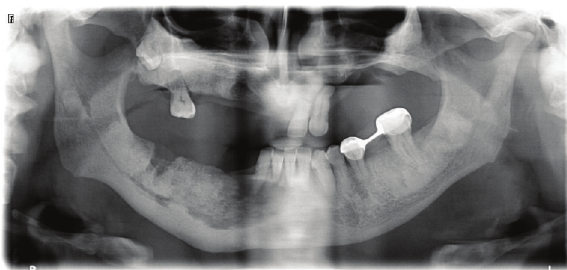
Figure 3: Postoperative panoramic radiography after bony seques- tra removed in 2013.